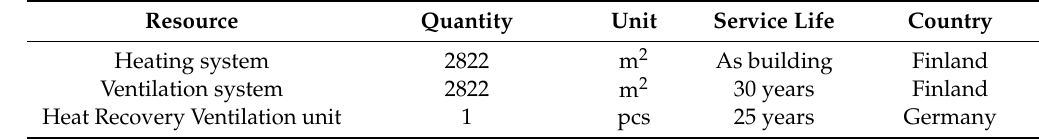
Table 5. HRV 21–22.7 dataset.